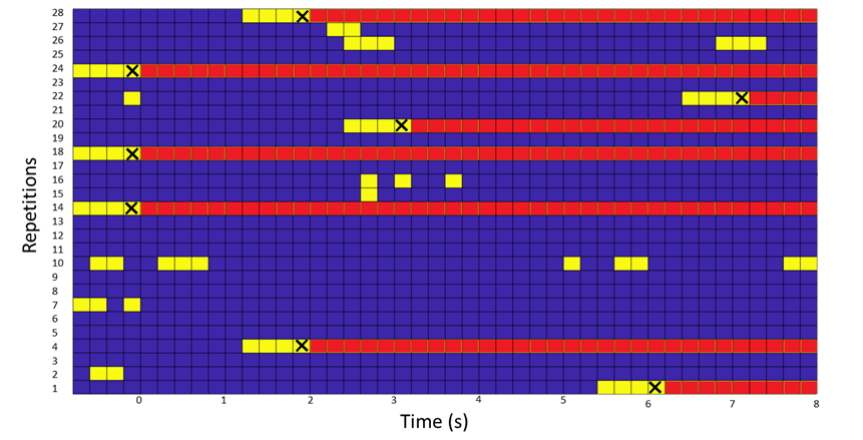
Figure 6. Figure with the FP of the subject who performed the test in real time. On the Y-axis, the number of repetitions performed and on the X-axis, the time elapsed since the start of the task that supports the sending of BMI commands. If the BMI detects the class intention to turn, the instant (frame) is displayed in yellow. If four consecutive FPs occurred, the person was forced to turn (instant of the verbal command marked with an X) and in the figure the remaining moments are plotted in red. Table 8. Table with the results of the 1st phase and 2nd phase of the online test. Results of each of the repetitions. If in the 1st phase, there was a PF, it is indicated with a 1 in the first phase and the time it took to happen. If in the 2nd phase there was a TP, it is indicated with a 1 and the interval in which it occurred, with a + sign if it was before the real turn or with a - sign if it was after the real turn. If a command occurred in the 2nd phase outside the valid metrics, FP was counted with a 1, otherwise a